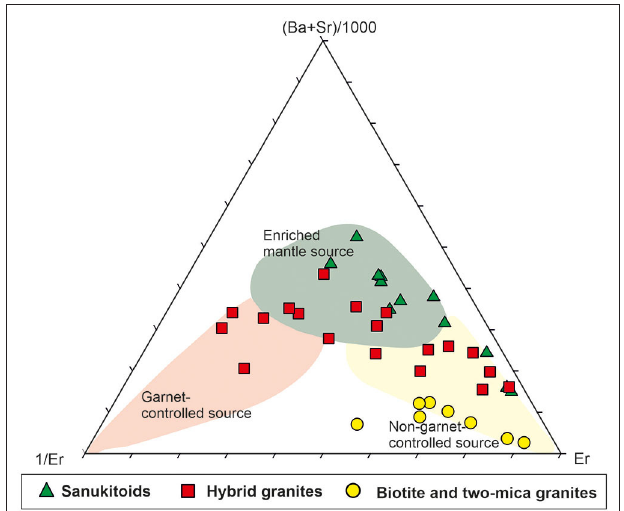
FIGURE 7 | Triangular plot using the discriminants Ba + Sr/1000, 1/Er and Er to differentiate the enriched mantle, garnet-controlled and non-garnet-controlled sources (after Heilimo et al., 2010).